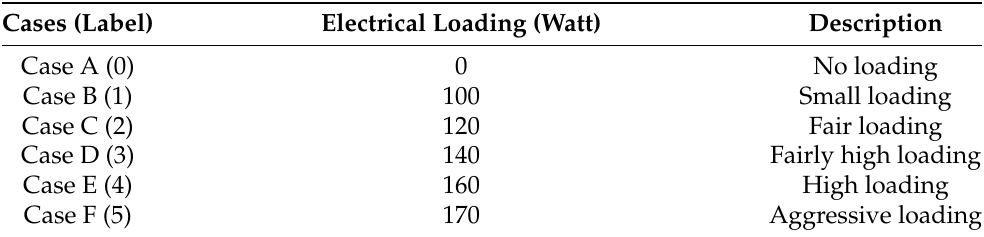
Table 3. The loading conditions for the experiment.